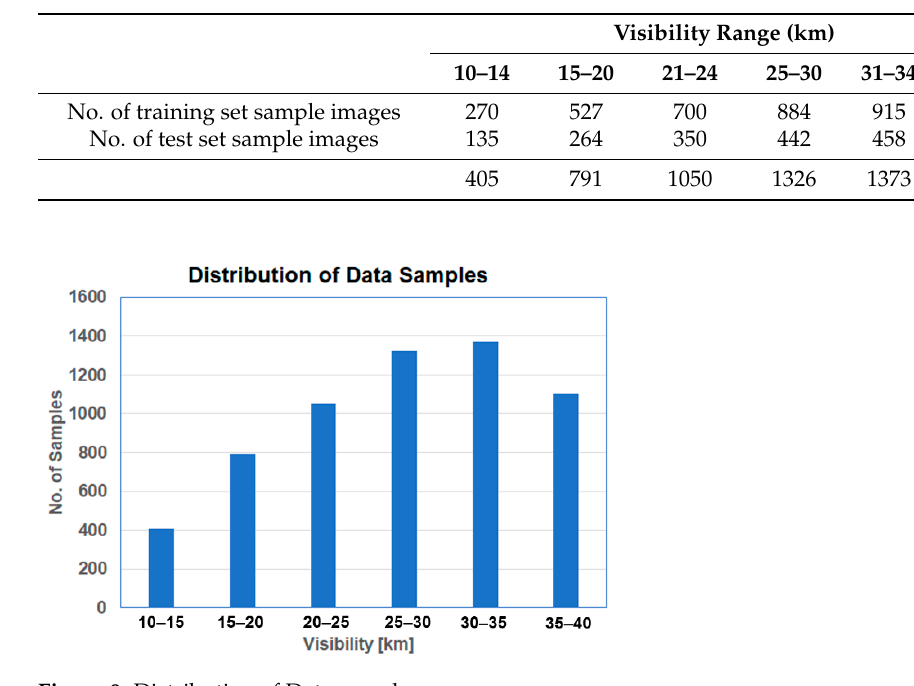
Figure 9. Distribution of Data samples.